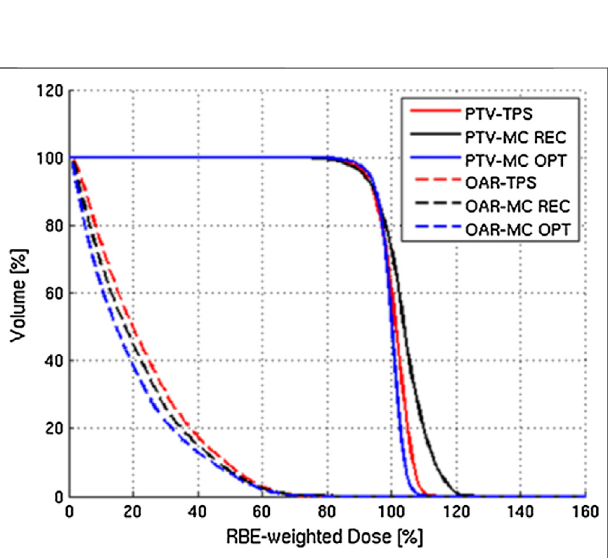
FIGURE 9 | Example ofresults of the MC TPS tool ofMairani et al. [220]: DVHs for PTV and OAR calculated for a three- fi eld patient case (chordoma in thehead – neckdistrict).ThestandardTPSresults(labeledTPS)arecompared with the MC-recalculated (labeled MC REC) and MCTP (labeled MC OPT)